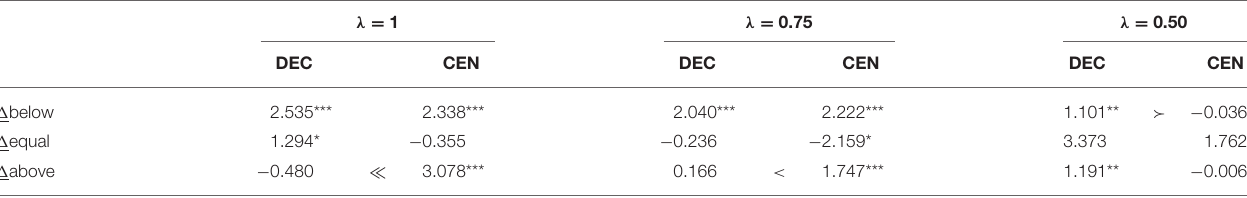
TABLE 6 | Difference in change in contributions after punishment vs. no punishment. λ = 1 λ = 0.75 λ =